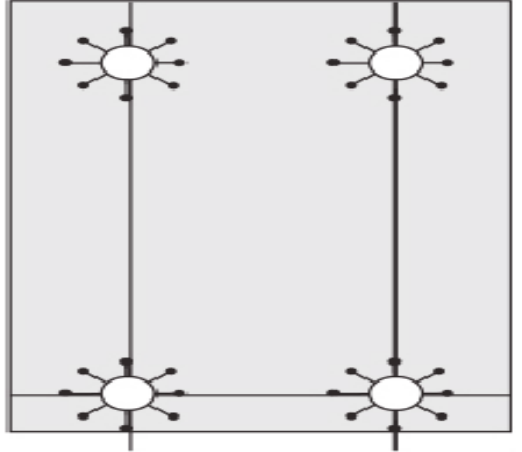
Figure 6: Radial displacement loading